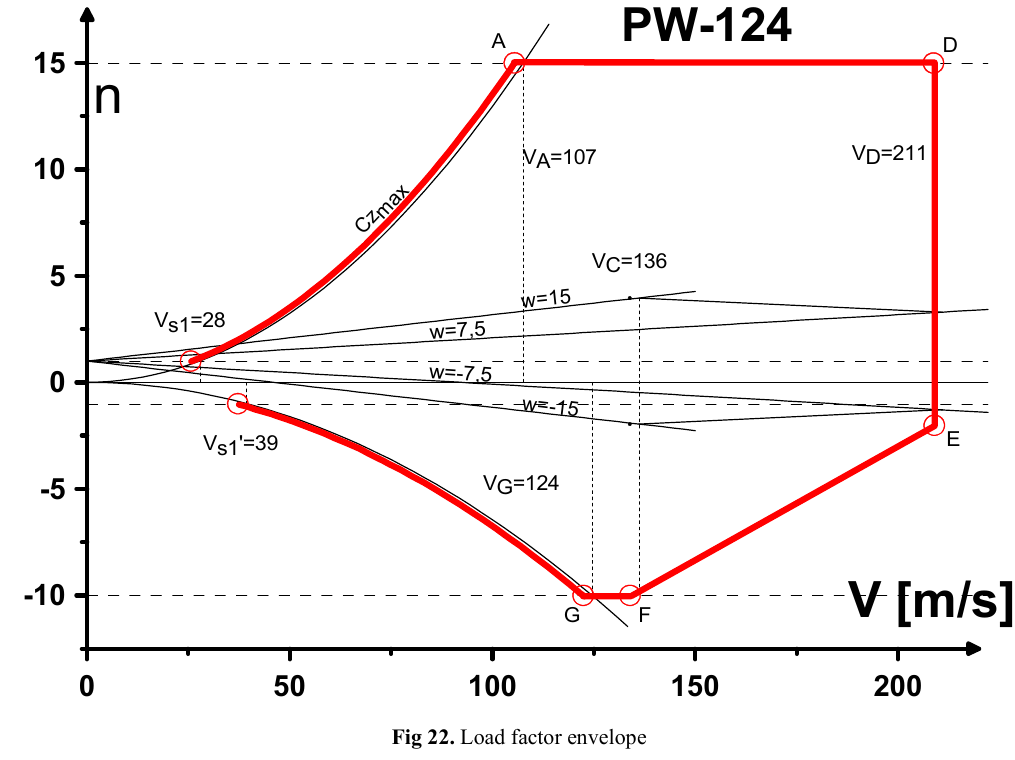
Fig 22. Load factor